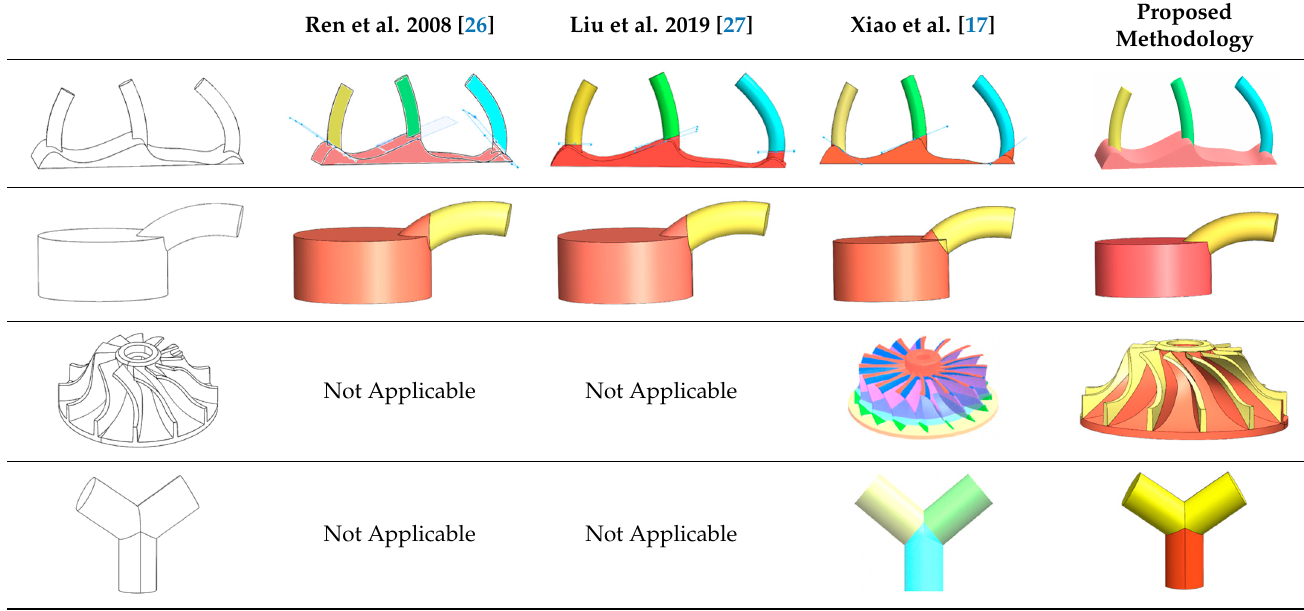
Table 3. Robotic additive slicing and path planning strategies overview.